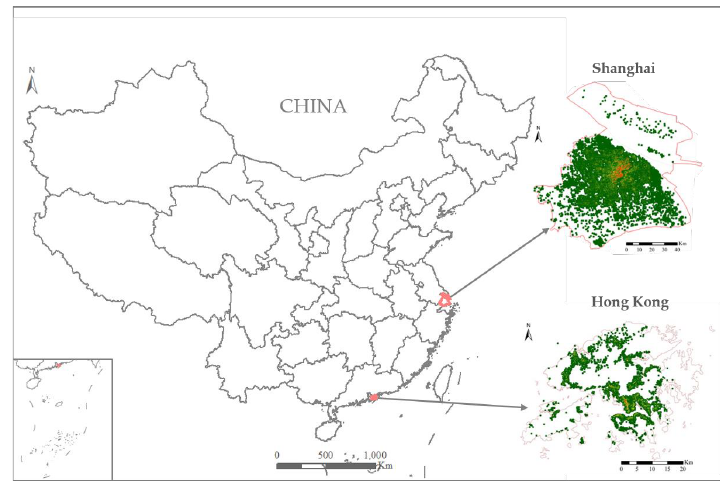
Figure 1. Locations of Hong Kong and Shanghai in China.